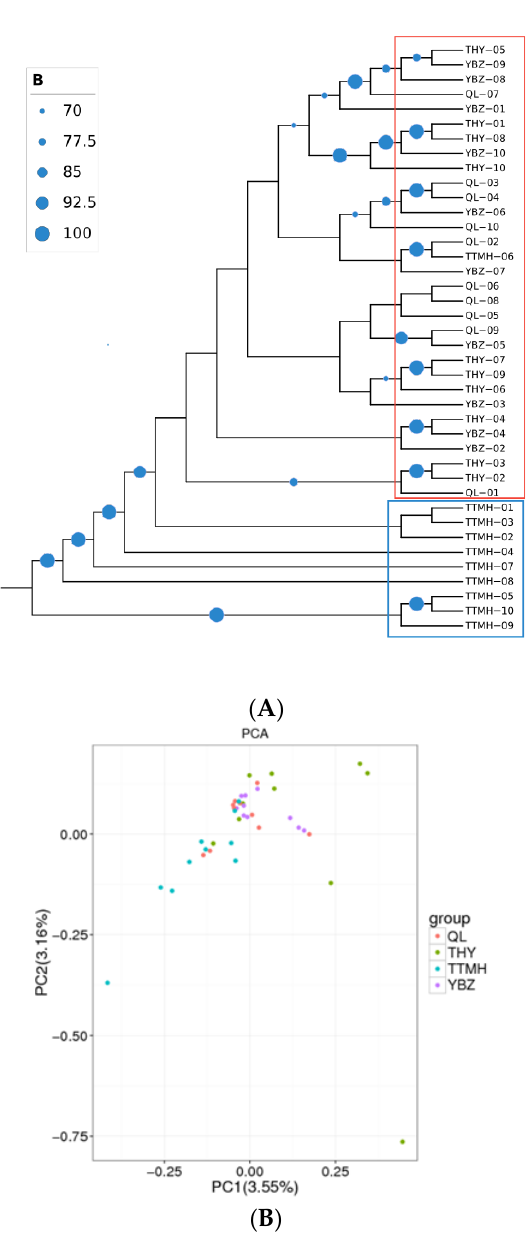
Figure 3. The NJ tree of 40 individuals based on SNPs ( A ) and the PCA plotting of the individuals from different locations ( B ). The size of the blue circle at the node represents the size of the bootstrap value and squares with different colors represent different clusters (blue: cluster 1; red: cluster 2) in Figure 3A.